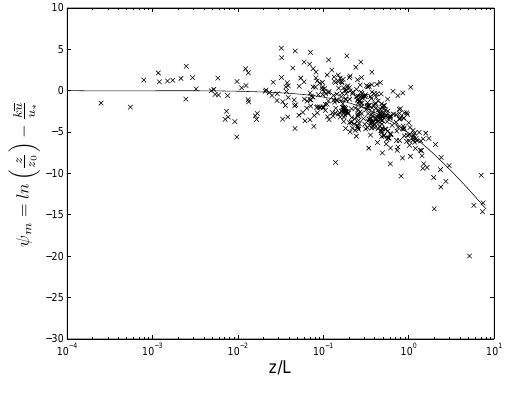
(cid:16) z (cid:17) − ku . Solid z 0 u ∗